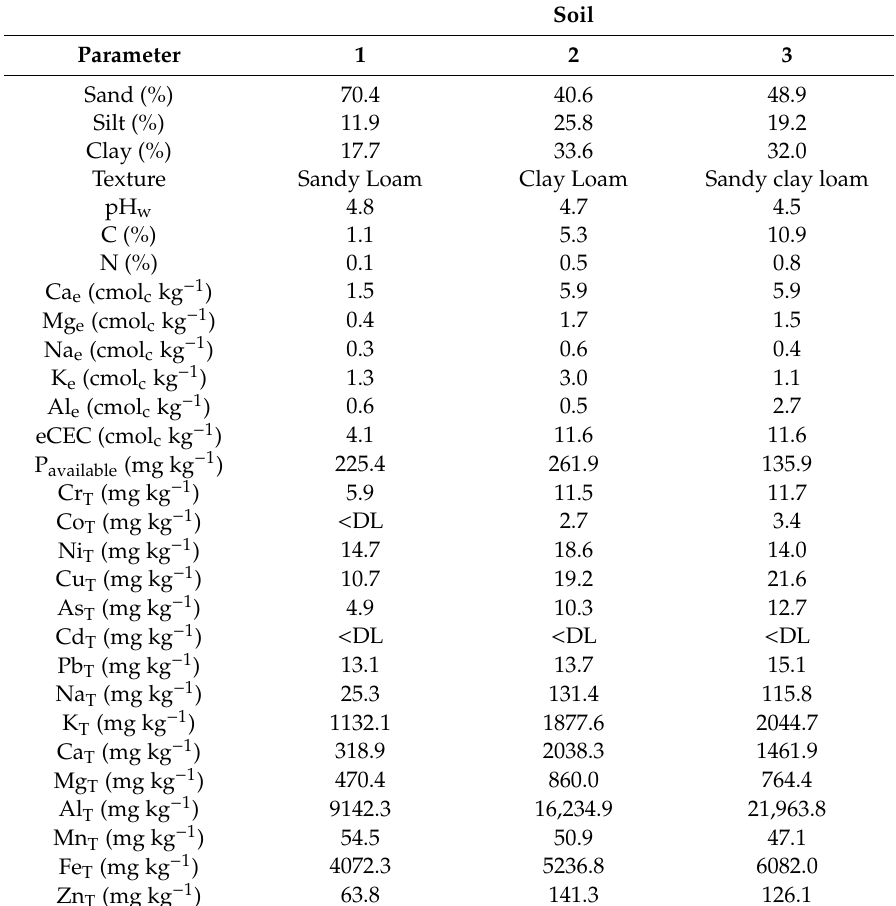
Table 1. General characteristics of the three soils used.